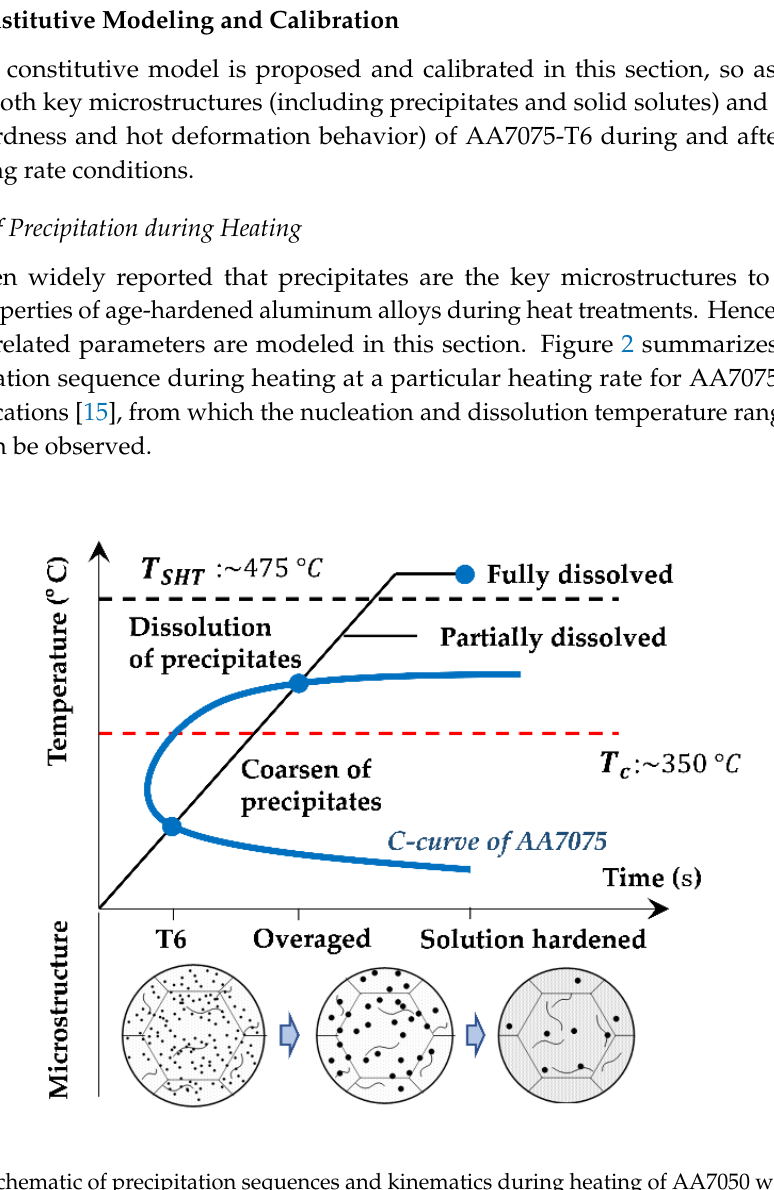
Table 3. Conditions for microstructure observations.